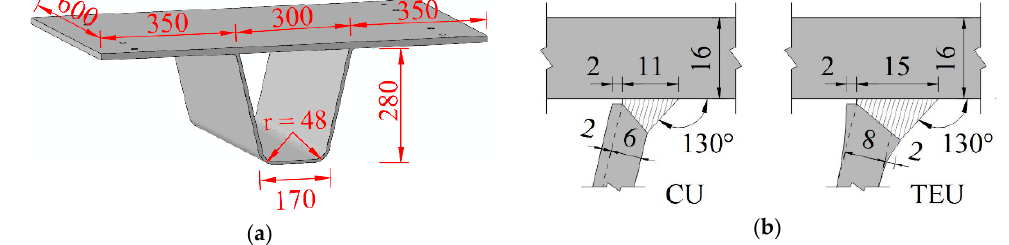
Figure 2. Schematic view of rib-to-deck specimens: ( a ) overview and ( b ) rib-to-deck joints.